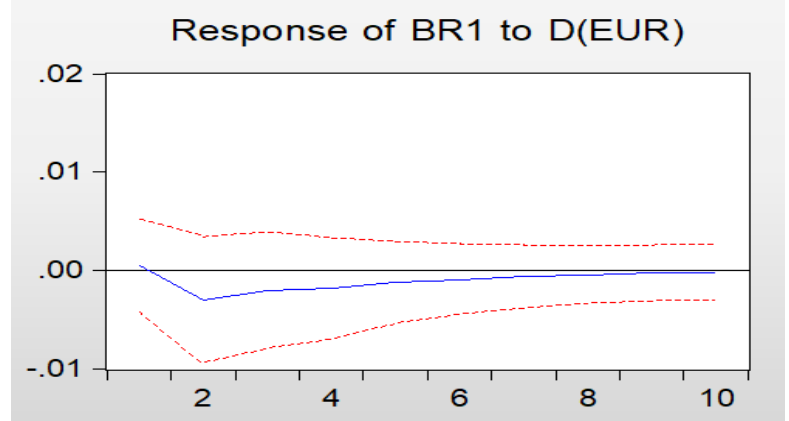
Figure 1. RESPONSE of BR1 to D